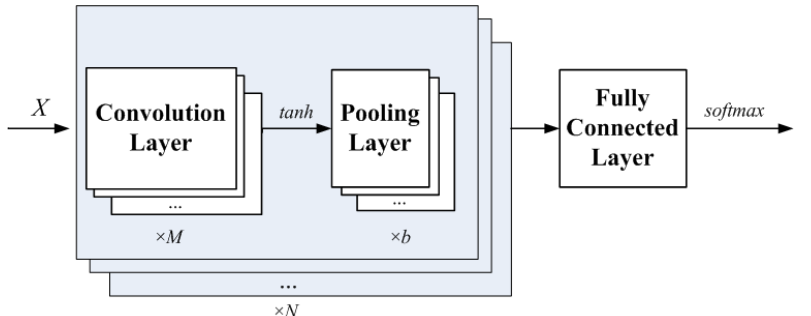
Figure 5. classical CNN